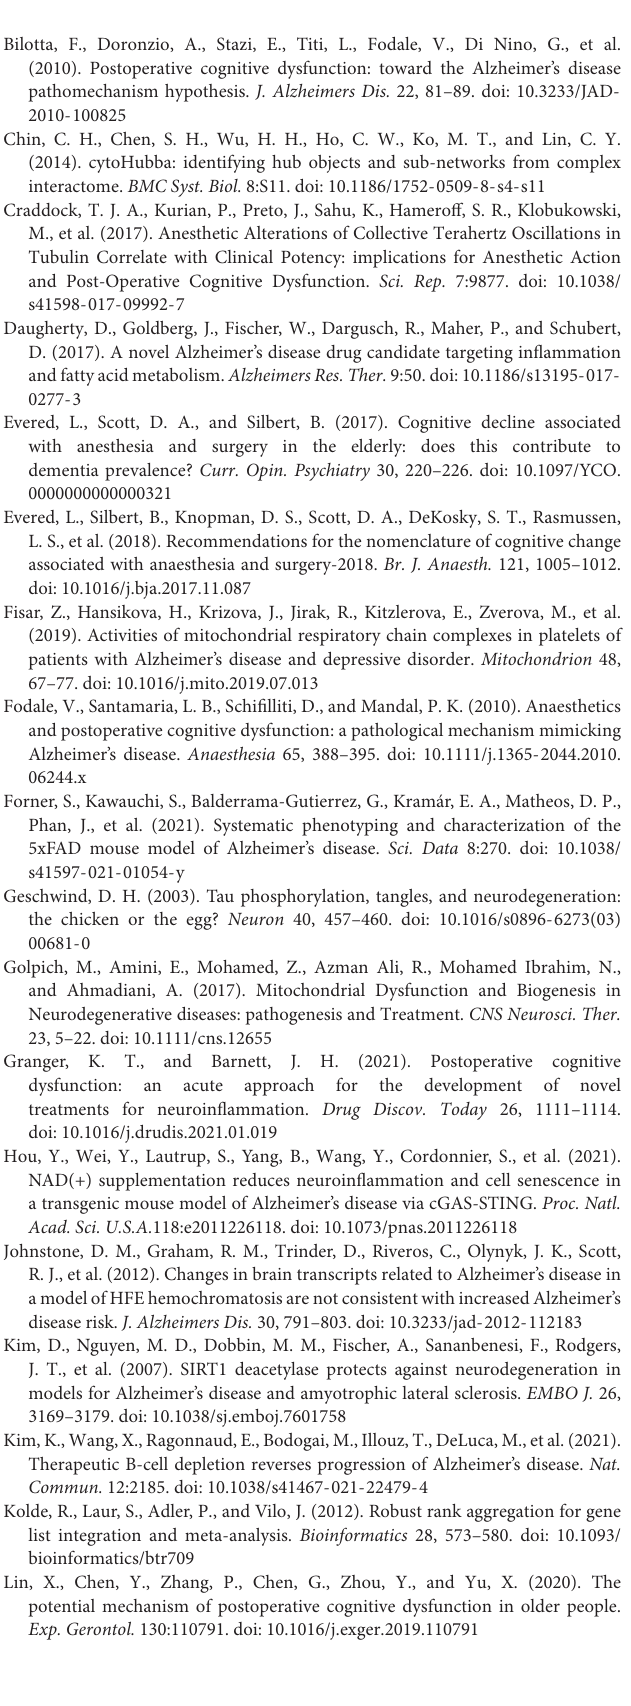
Frontiers in Aging Neuroscience |